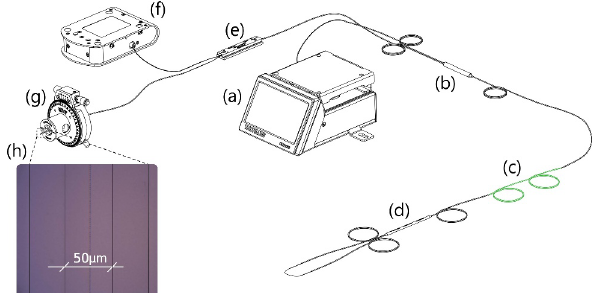
Fig. 2. Schematic diagram of the experimental L-band linear- cavity fiber laser setup